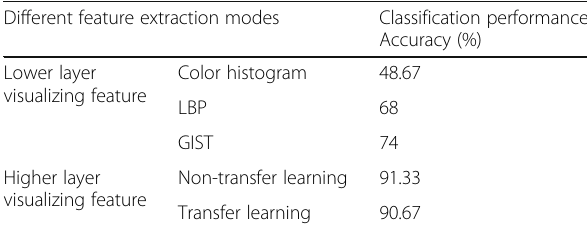
Table 2 Average classification performance comparison under the different feature extraction modes Different feature extraction modes